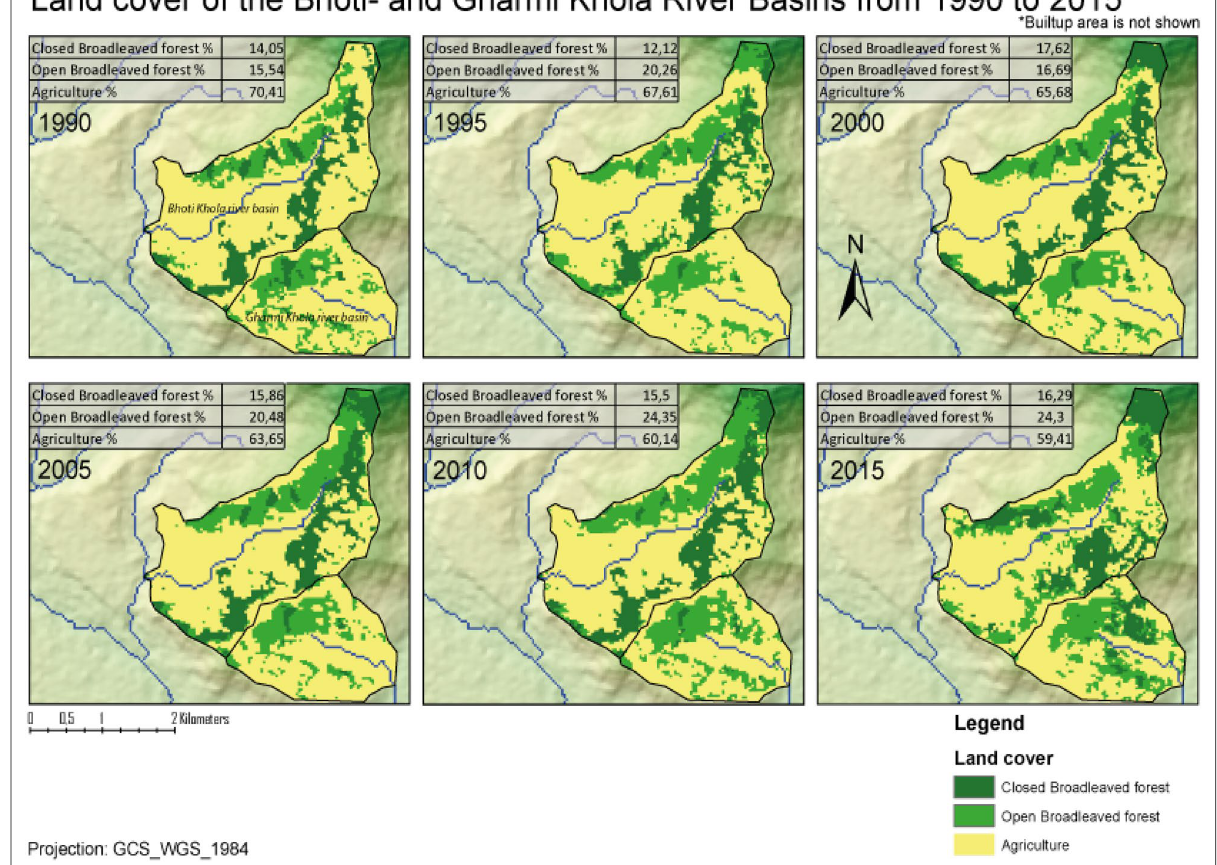
Fig. 9 Changes in land cover for Gharmi–Bhoti from 1990 to